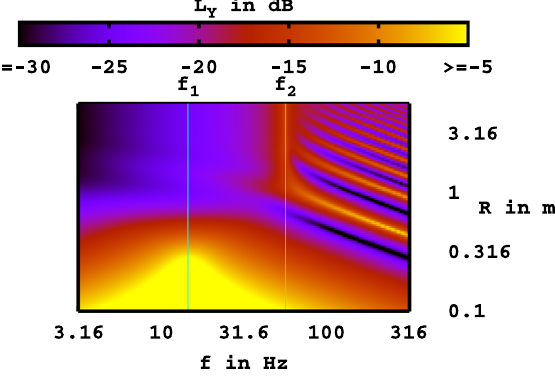
Figure 16. Level of admittance L Y according to (56).